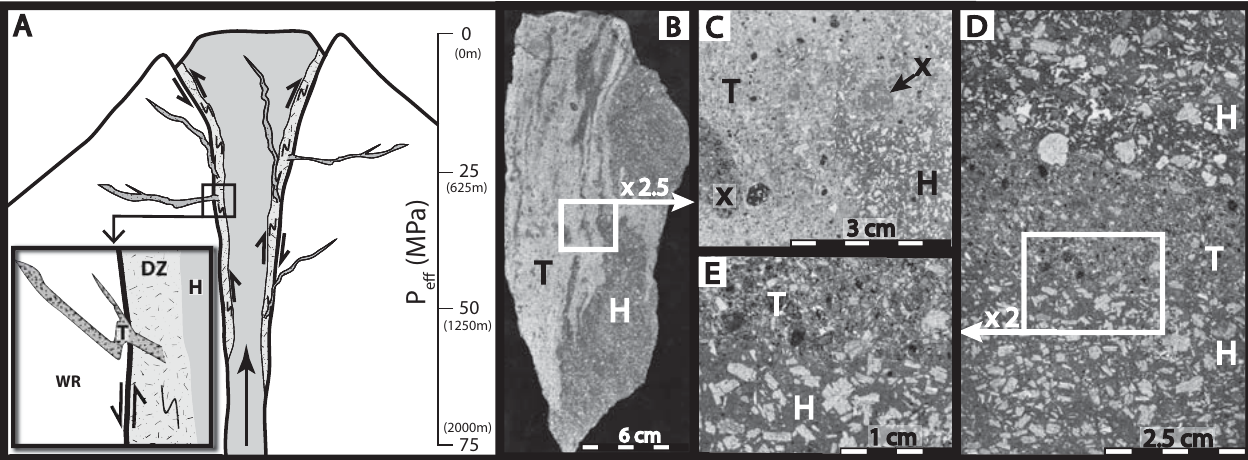
Fig. 1. (A) Cartoon of a dome building eruption showing the occurrence of tuffisite veins in volcanic edifices. (Tuffisite veins have been reported near the surface (Tuffen et al., 2003) and up to more than 500 meters depth (Heiken et al., 1988)) (B) Photograph of a slab cut from a tuffisite (T) bearing sample of andesite (H) from Colima, Mexico. (C) Scanned thin section prepared from the slab in (B) showing rounded lithic clasts (X). (D) Scanned thin section of an approx. 1cm wide tuffisite vein. (E) Zoom on the interface between host rock (H) and tuffisite (T).